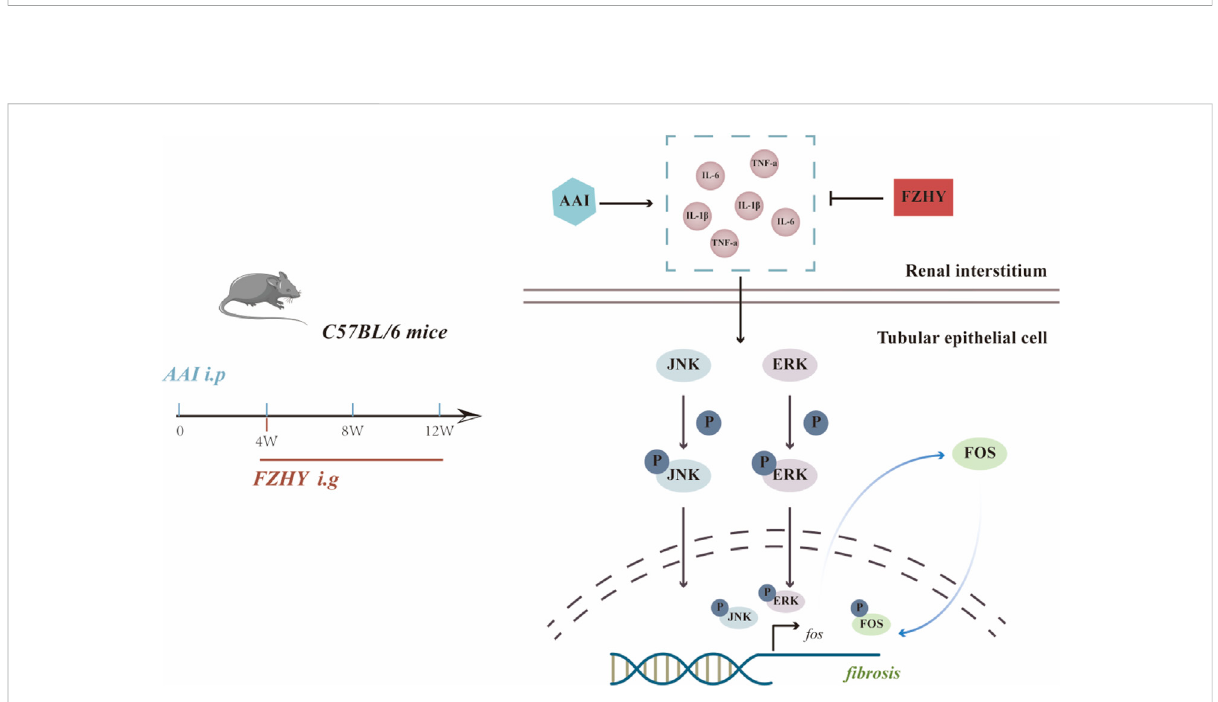
FIGURE 8 Diagram depicting the potential mechanism of FZHY against the renal fi brosis induced by